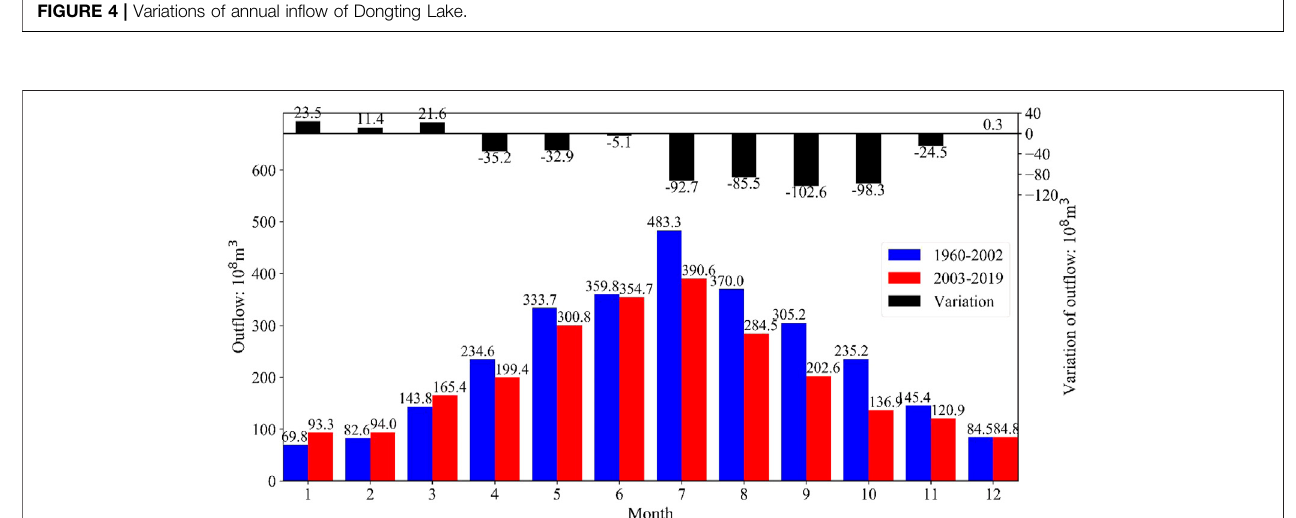
FIGURE 5 | Out fl ow volumes and variations of Dongting Lake at different time